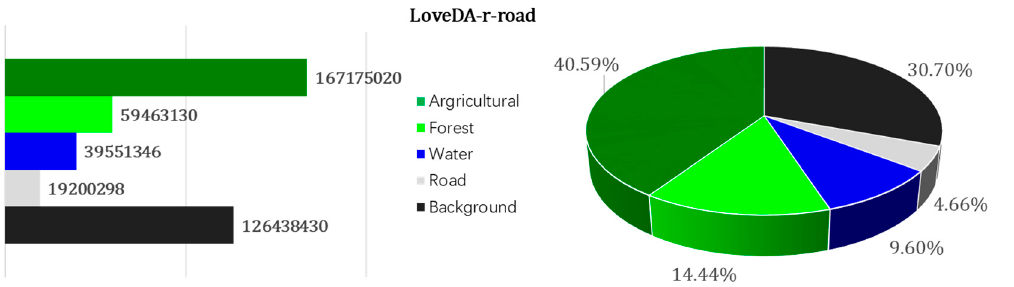
Figure 3. Number and percentage of pixels in each classification sample in the LoveDA-r-road da- taset.